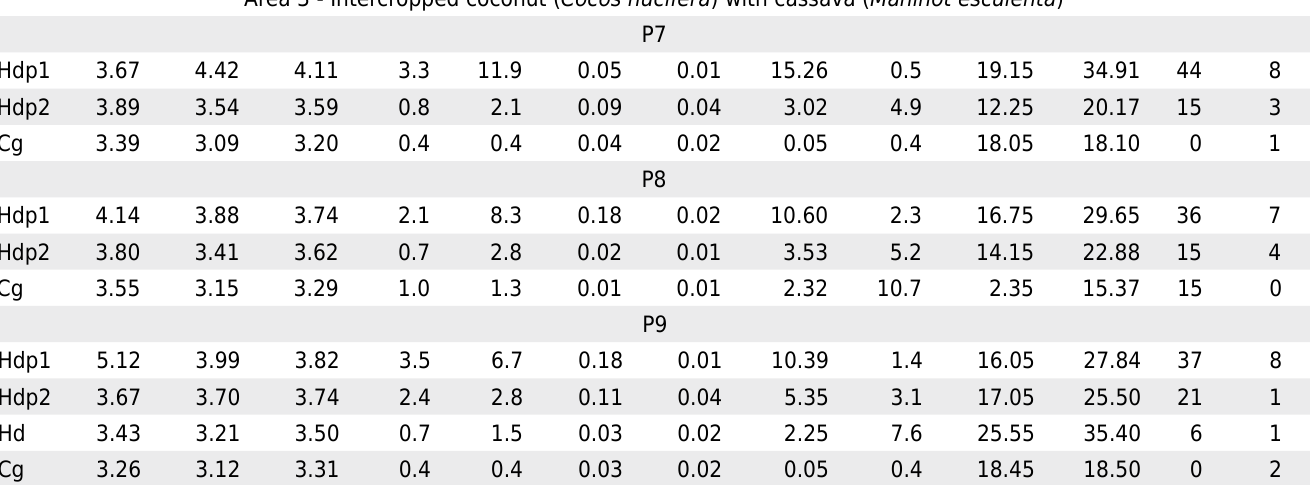
Table 3. Chemical properties of the studied Histosol profiles Hor